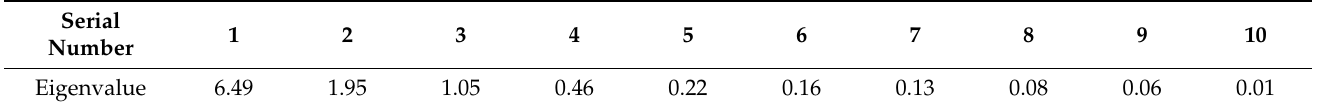
Table 3. Ten largest eigenvalues of S60.